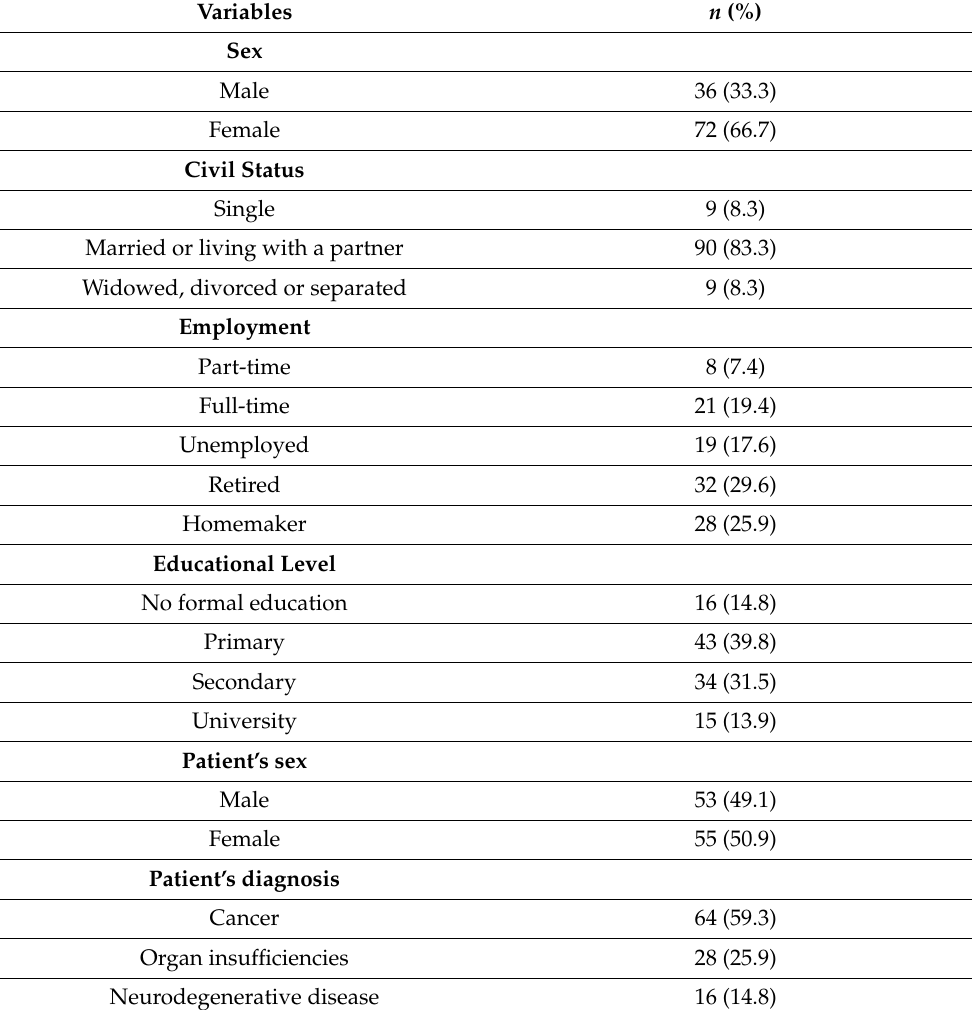
Table 1. Sociodemographic data of participants ( n =